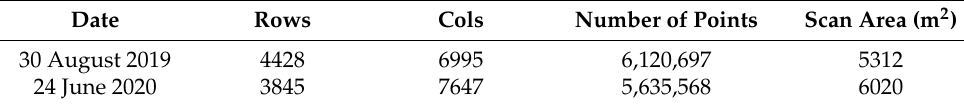
Table 1. Detailed parameters of the 3D laser scan.